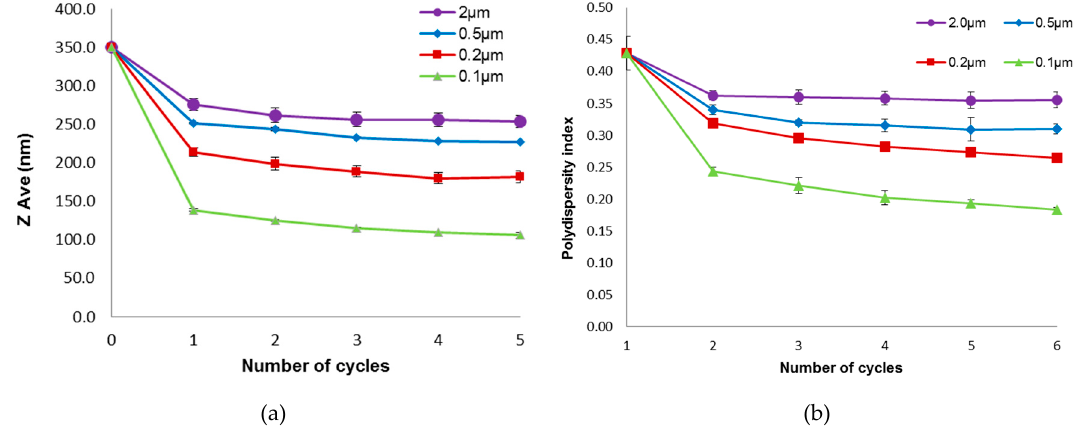
Figure 4. Influence of membrane pore size on the ( a ) particle size and ( b ) polydispersity index of the extruded liposomes (Mean ± SEM, n = 6).